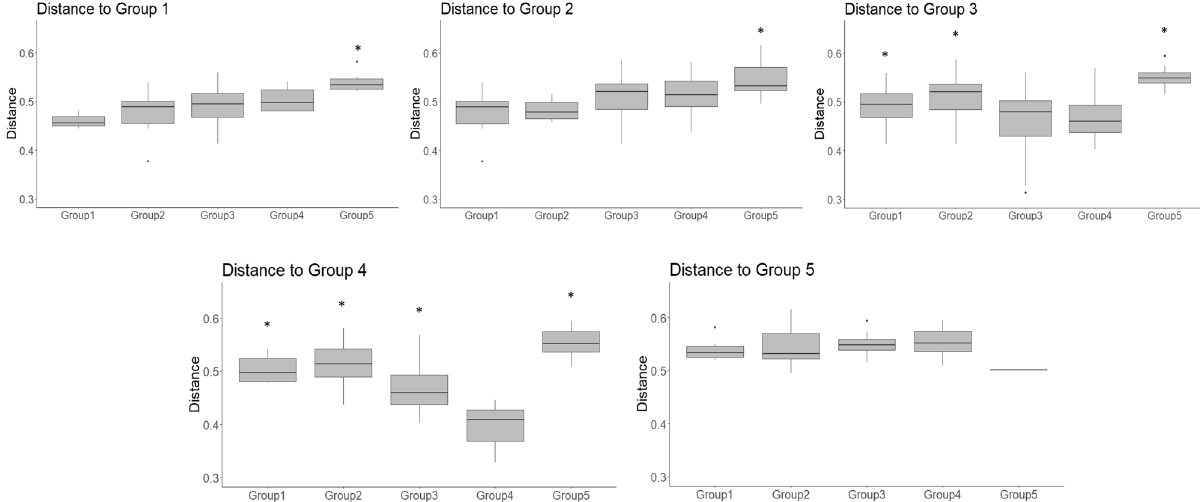
Figure 3. Beta group significance analysis of Unweighted distances between five categories based on the time period during the reintroduction process. Group (1) Between − 100 and − 52 days prior to liberation, Group (2) Between − 52 and 0 days prior to liberation, Group (3) Between 0 and 100 after the liberation, Group (4) From 100 days until the end of the study for the released individuals and Group (5) From 100 days until the end of the study for the recaptured individual. Asterisk represent statistical differences ( p < 0.05) between the different groups and the group being compared.